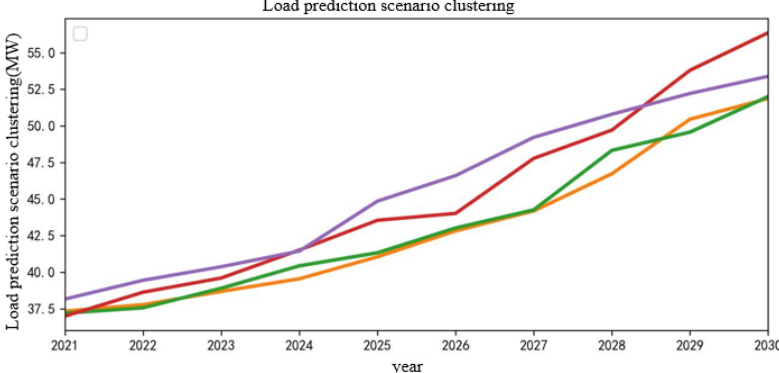
Figure 12. Load scenarios in the next 10 years after reduction.